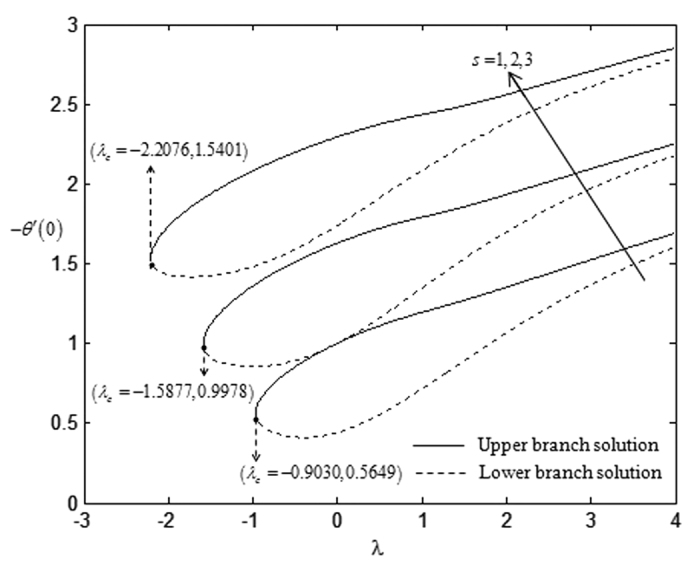
Variations of −θ′(0) with λ for some values of s when β = −1 and K = 1.